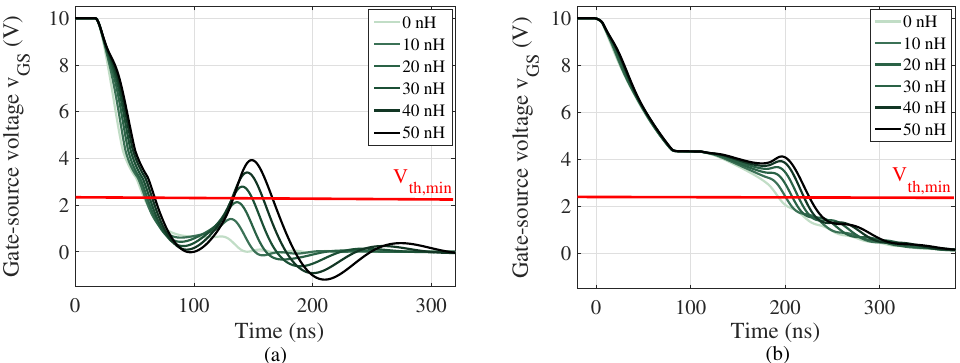
Figure 10. The gate-source voltage at the T HS turn off with ( a ) R g,off = 0 Ω and ( b ) R g,off = 10 Ω for L s =